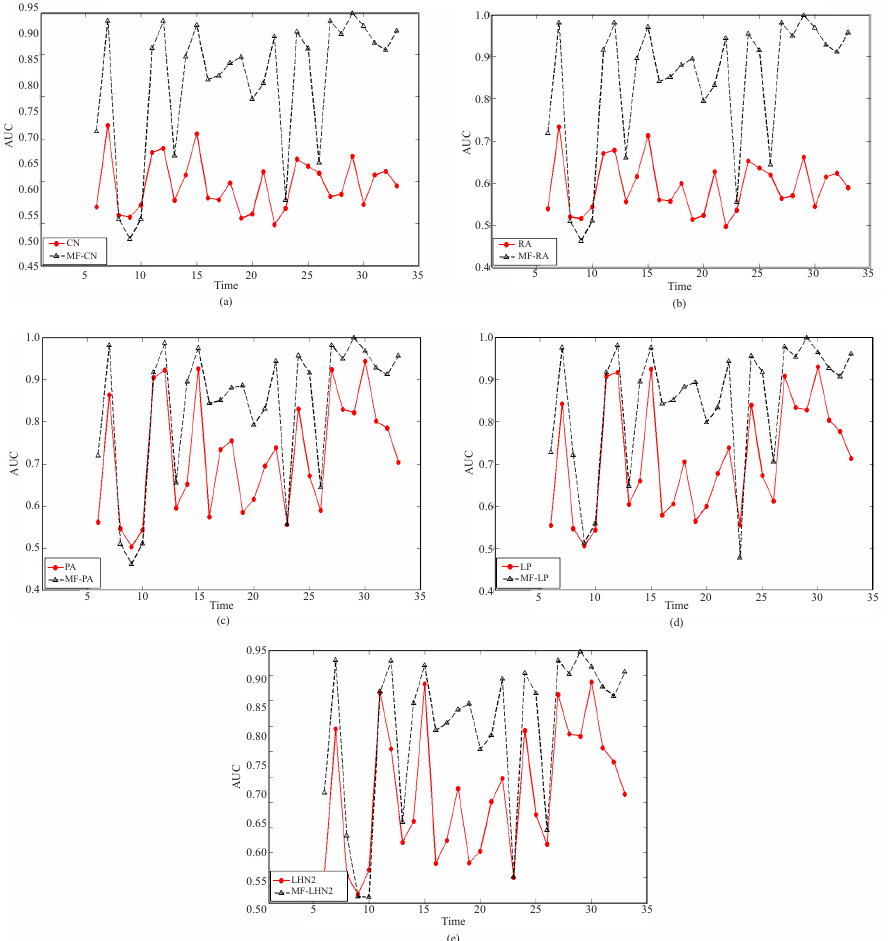
Fig. 4 Performance of different methods on